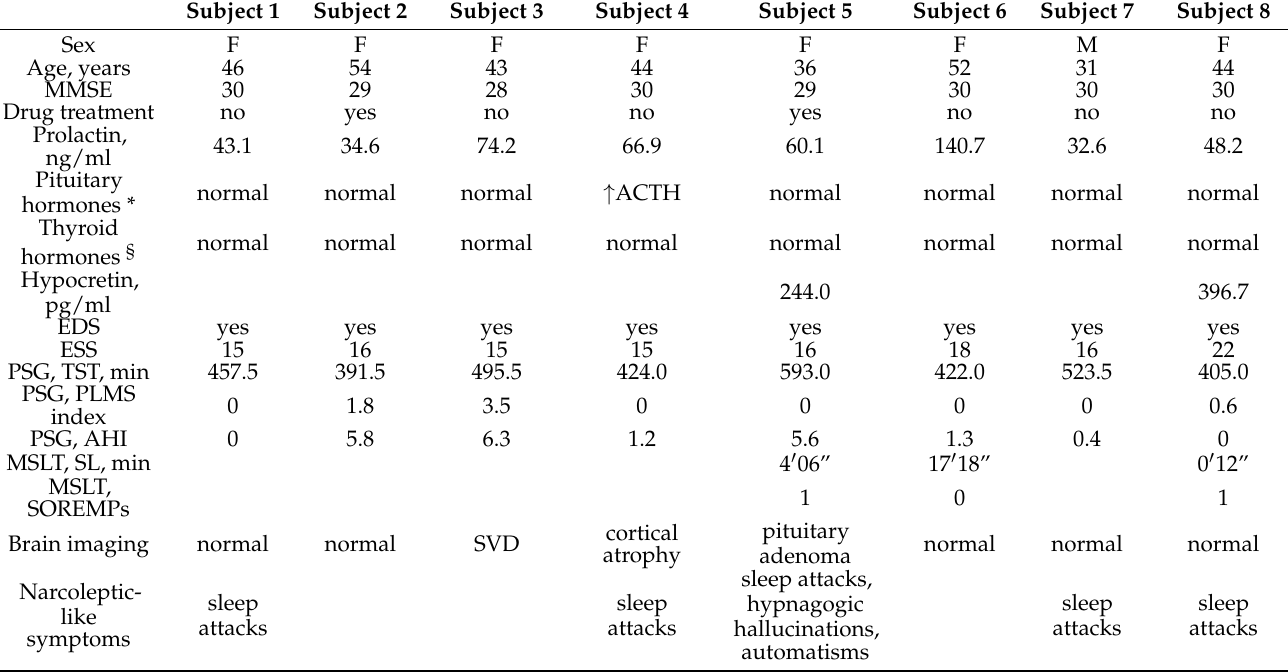
Table 2. Clinical features and laboratory findings in high prolactin (hPRL) participants with a complaint of excessive daytime sleepiness and without another sleep